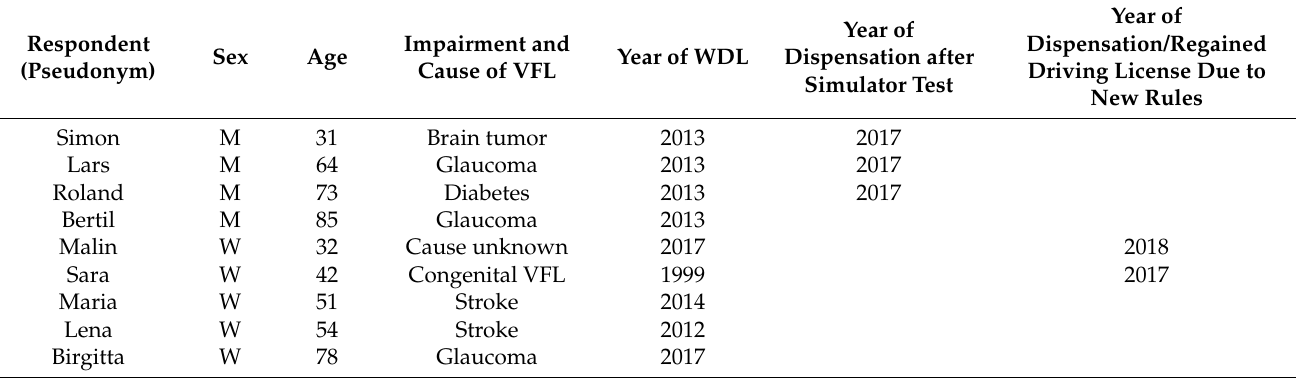
Table 1. Respondents: background